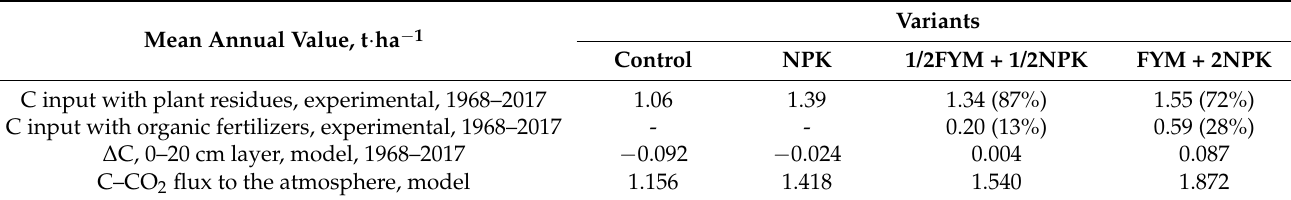
Table 3. Indicators of organic carbon balance in a long-term experiment (1968–2017).